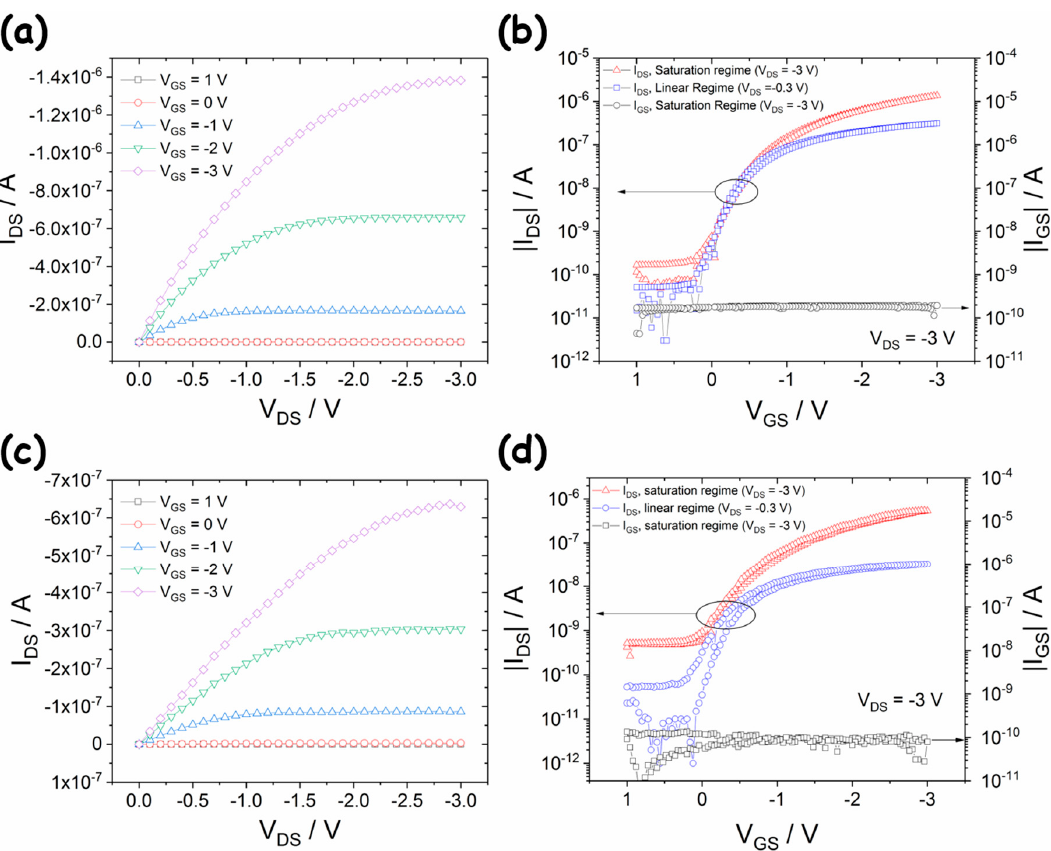
Figure 2. Typical output ( a ) and transfer characteristic curves ( b ) of OFETs fabricated over 175 μ m-thick PET substrates; typical output ( c ) and transfer characteristic curves ( d ) of OFETs fabricated over 700 nm-thick Parylene C substrates.